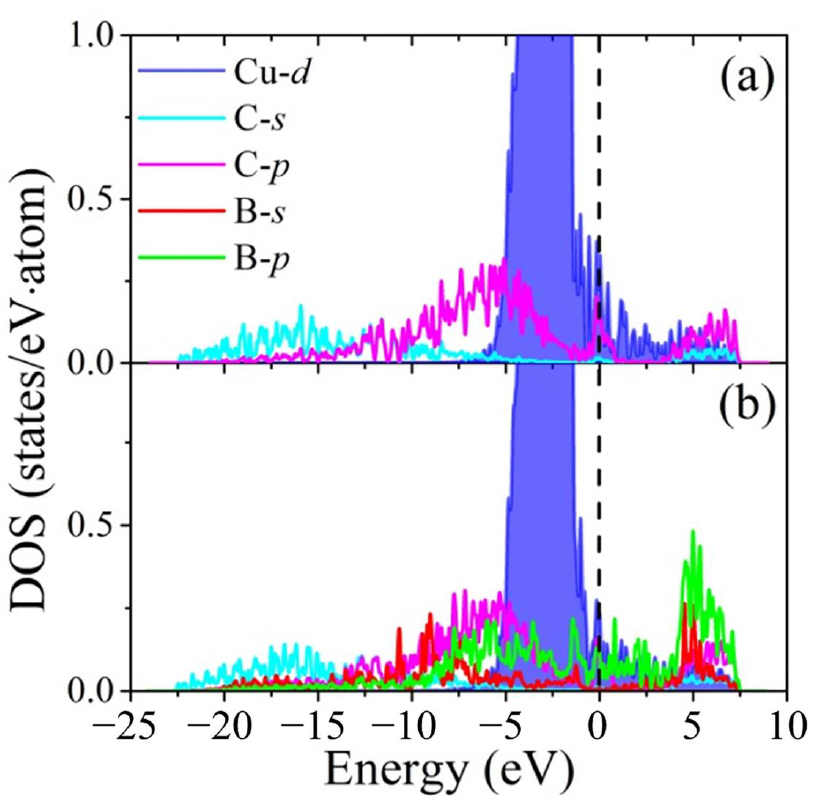
Figure 6. Density of states (DOS) for ( a ) pure and ( b ) boron-segregated diamond/Cu-B interfaces. The dotted line represents the Fermi level.